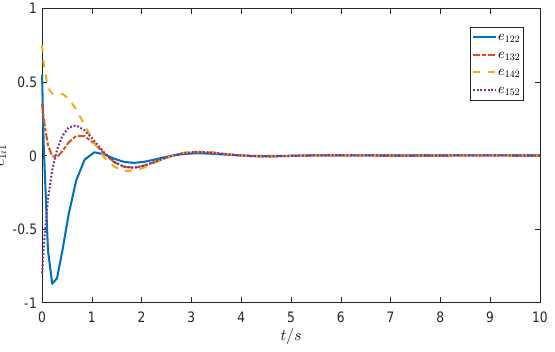
Figure 4. The state response errors e 1 i 2 under the initial state x 0 and the control input u i .